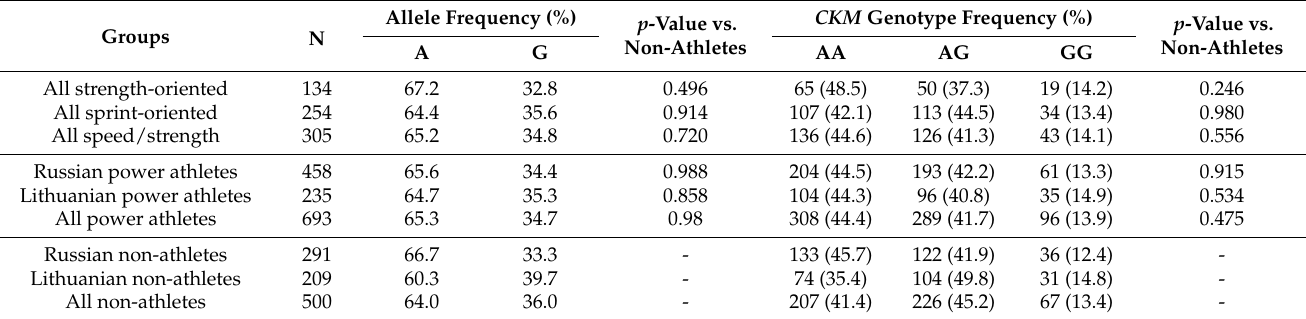
Table 1. Genotype and allele frequencies of the CKM rs8111989 SNP in athletes and non-athletes from Russia and Lithuania.